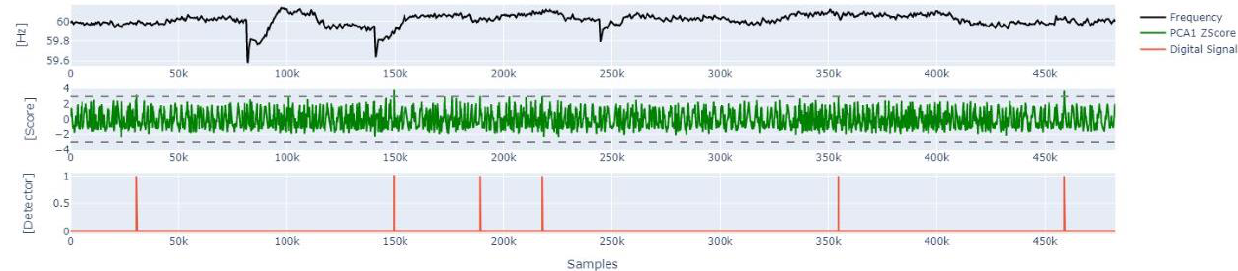
Figure 14. Event 2: detector event of PMU Cascavel (located at Parana State).